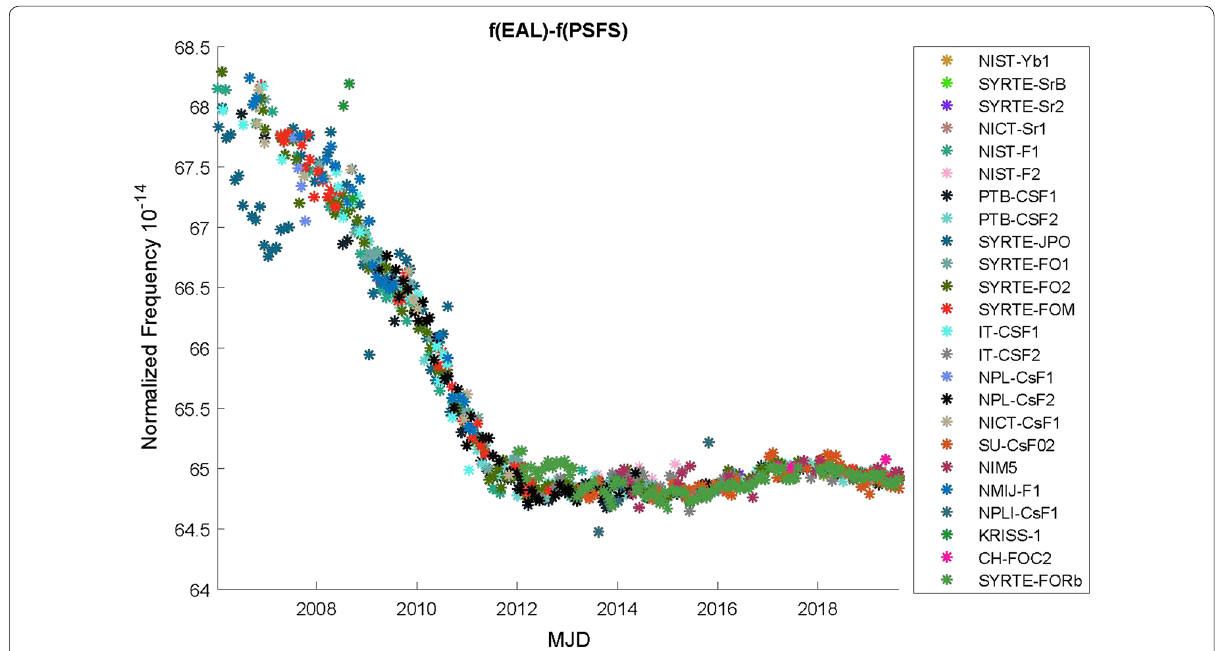
Fig. 7 Measures of the EAL frequency offset versus primary and secondary standards. The code of the standard is reported in the legend (see BIPM Annual reports https ://www.bipm.org/en/bipm-servi ces/times cales /time-ftp/annua l-repor ts.html)